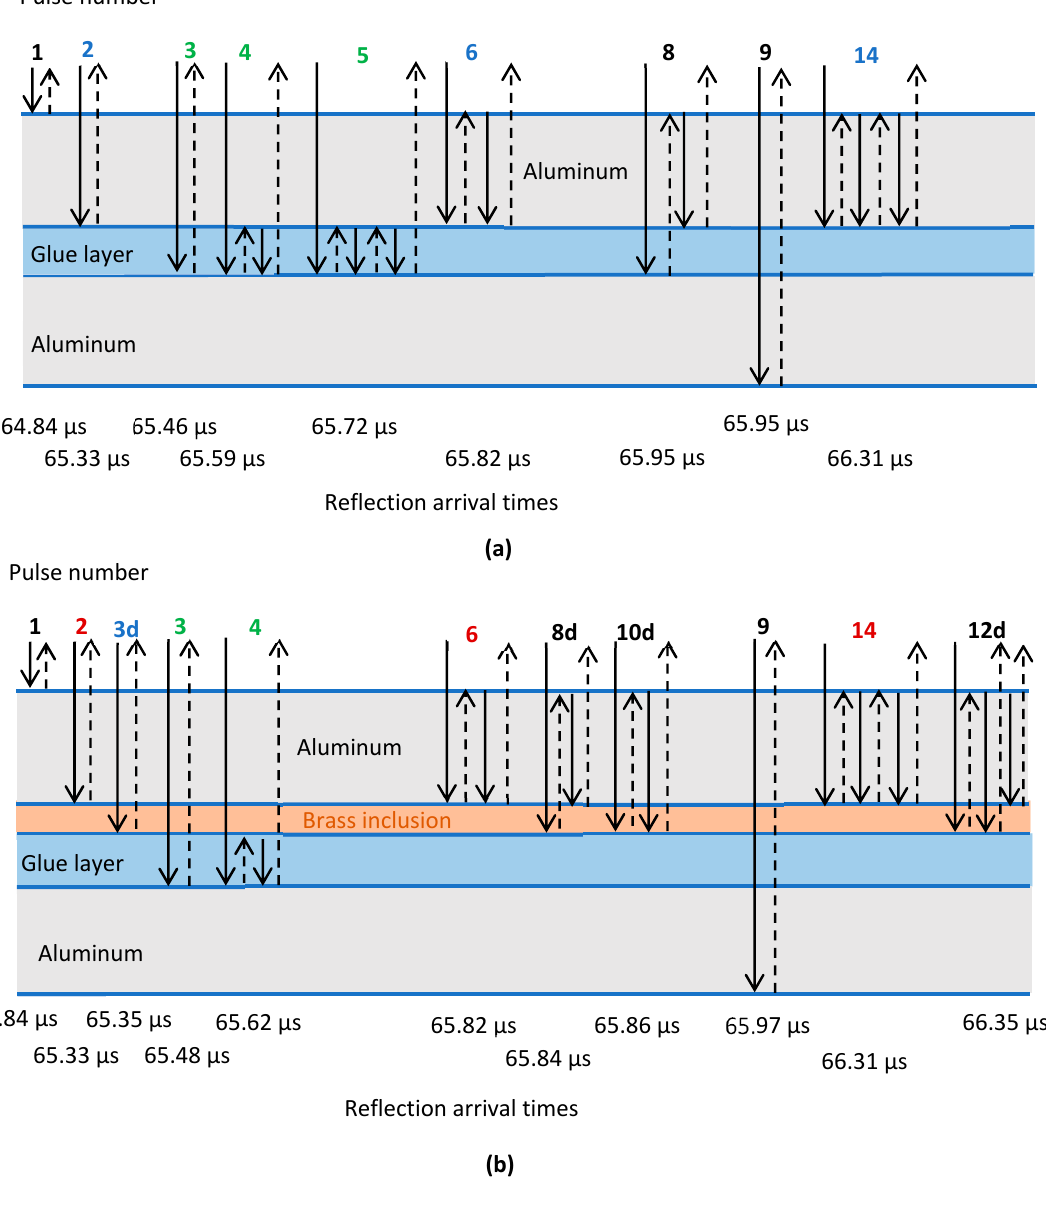
Figure 6. Ultrasonic wave propagation paths through the boundaries and time instances for: ( a ) not defected and ( b ) defected options.